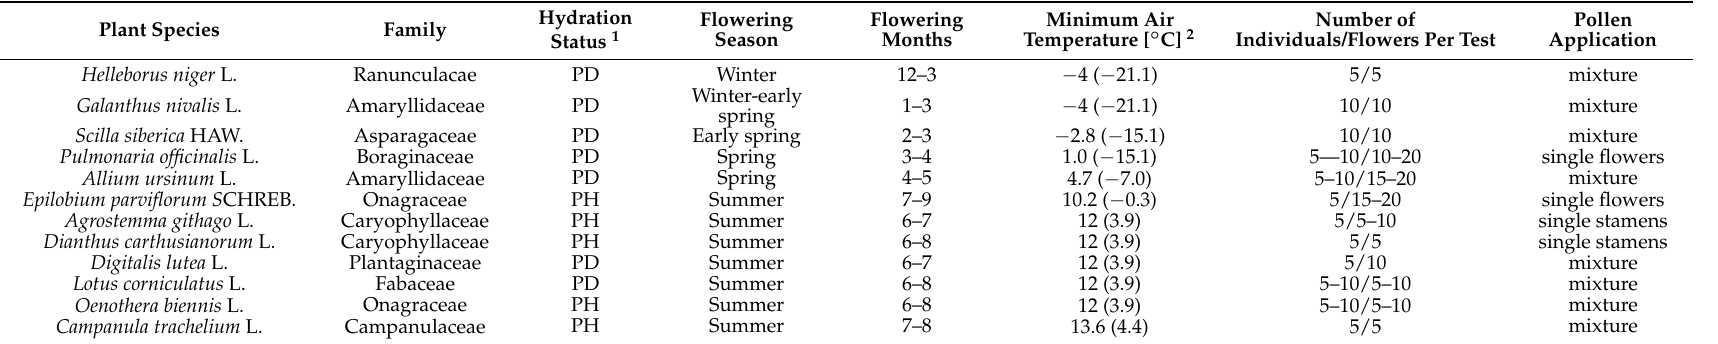
Table 1. List of investigated species with details on the pollen hydration status at dispersal, the flowering time, the mean minimum temperature and, in square brackets, the absolute minimum temperature in the coldest month of the respective flowering